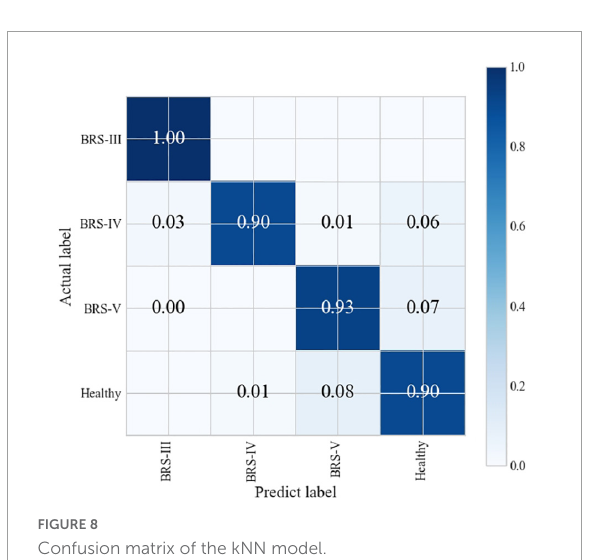
ROC of different classification models.